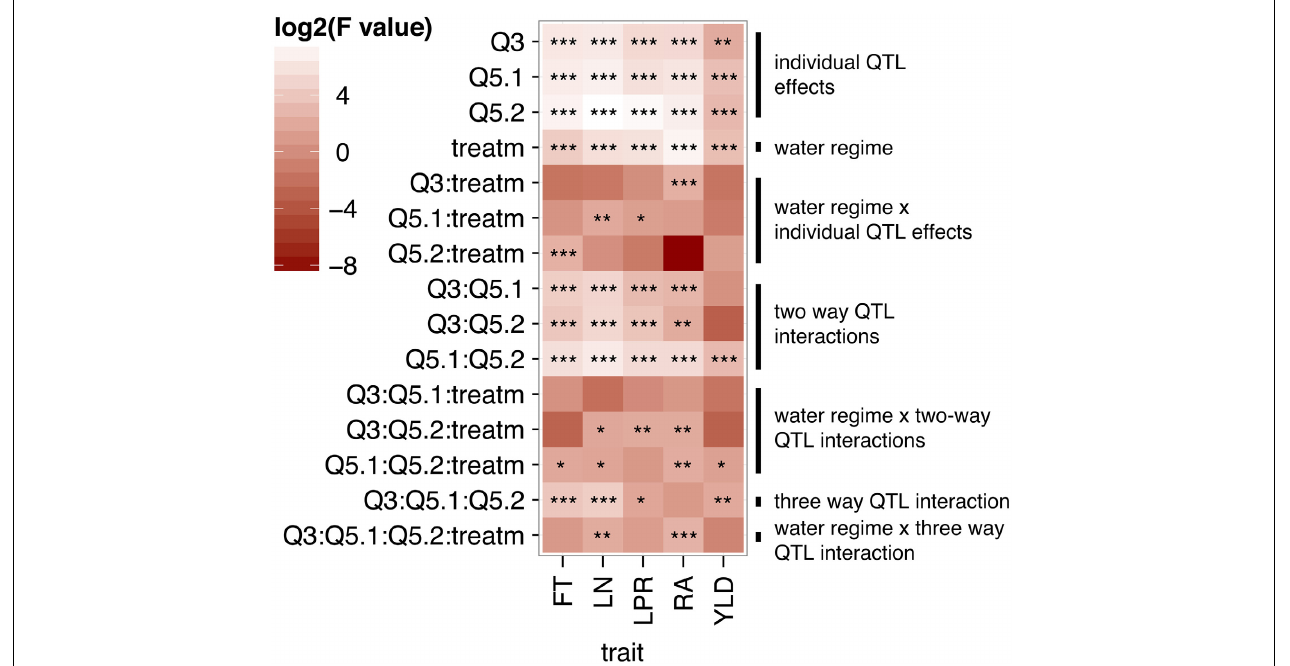
FIGURE 2 | Heatmap of log2( F -values) from an ANOVA conducted for the NIL drought stress experiment. Genotype at the three interacting QTL (Q.3, Q5.1, and Q5.2) and the water regime (ww and wd) were included as